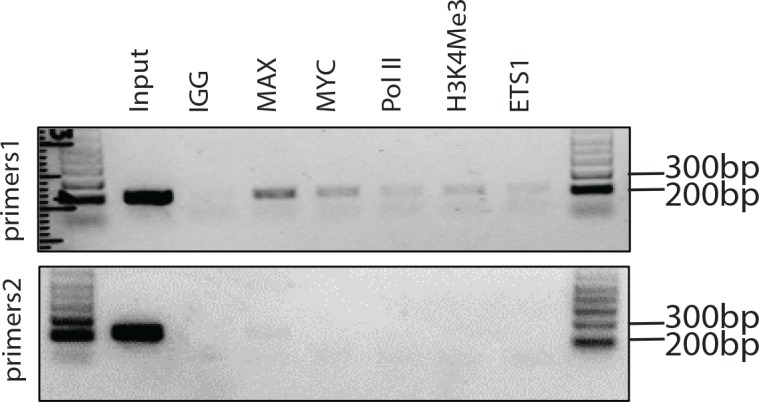
ChIP assay showing binding for the indicated factors to the promoter region (n = 3 each).IgG was used as control. The positions for PCR primers are shown in Figure 2F. Size of the marker was shown.